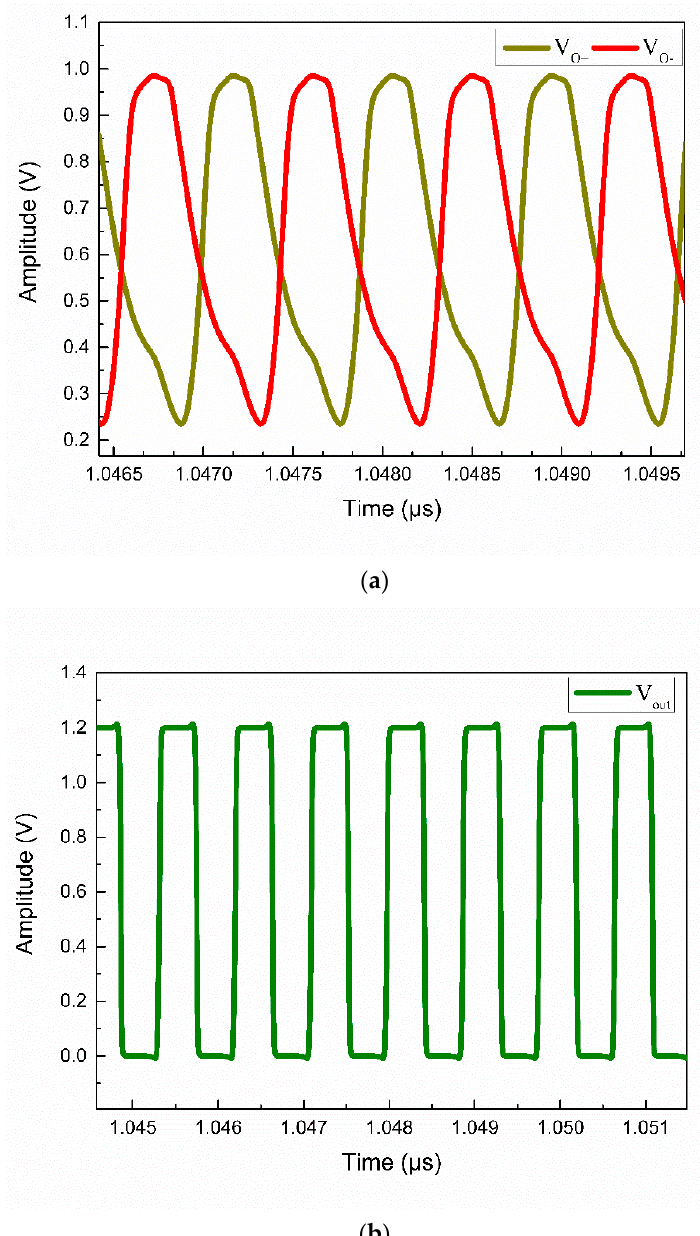
Figure 10. The waveforms of the input and output clocks of the DTS converter: ( a ) input clock; ( b ) output clock.